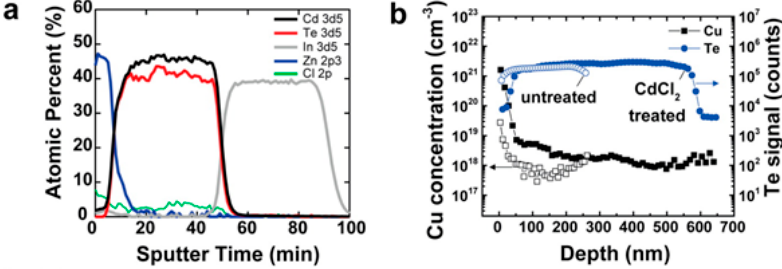
Figure 7. Depth profiling using ( a ) X ‐ ray photoelectron spectroscopy (XPS) and ( b ) secondary ion mass spectrometry SIMS. The XPS data and CdCl 2 ‐ treated SIMS samples (panel b, blue and black) were obtained from In:ZnO/CdTe/ITO stacks, while the untreated sample (panel b, open squares/circles) did not have a ZnO layer deposited to rule out In:ZnO film as the Cu source. The SIMS Te counts (circles) are shown as a guide to show the location of the interfaces. Reproduced with permission from [40]. Copyright 2014, American Chemical Society.